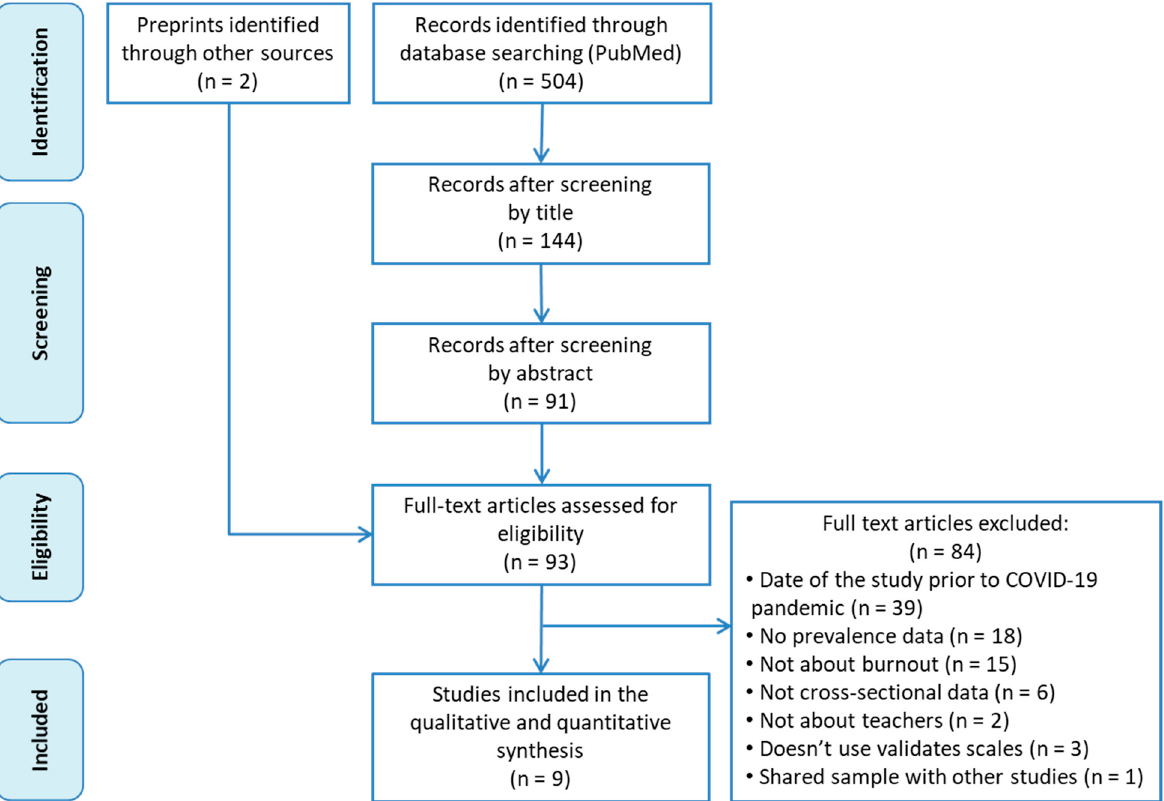
Figure 1. Flowchart of the study search and selection process.